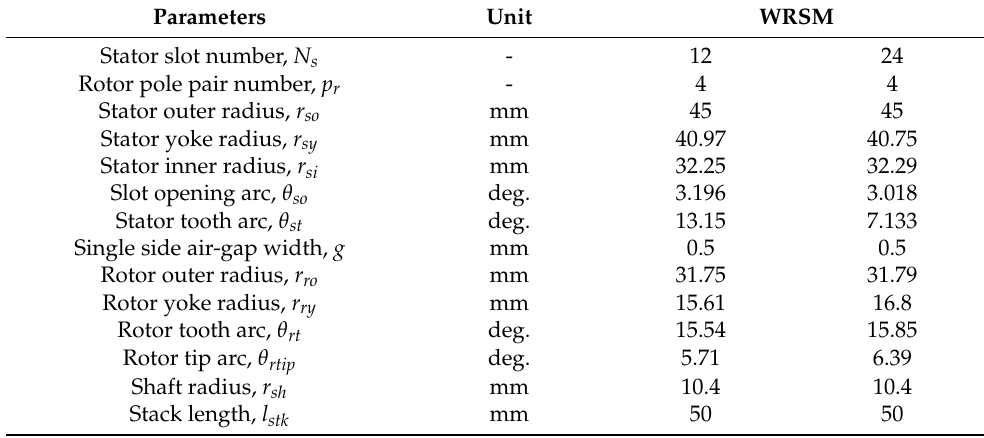
Table 1. Parameters of the Analyzed